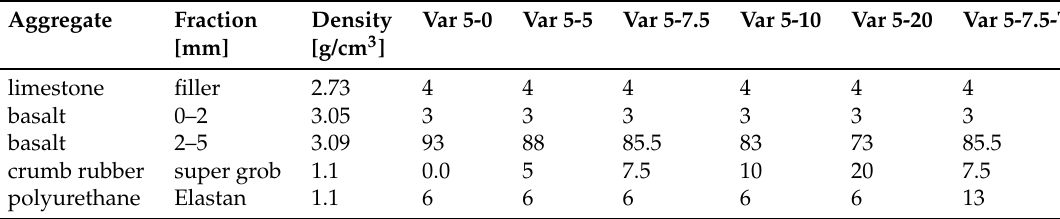
Table A1. Mixture composition of tested 5 mm variants in % by